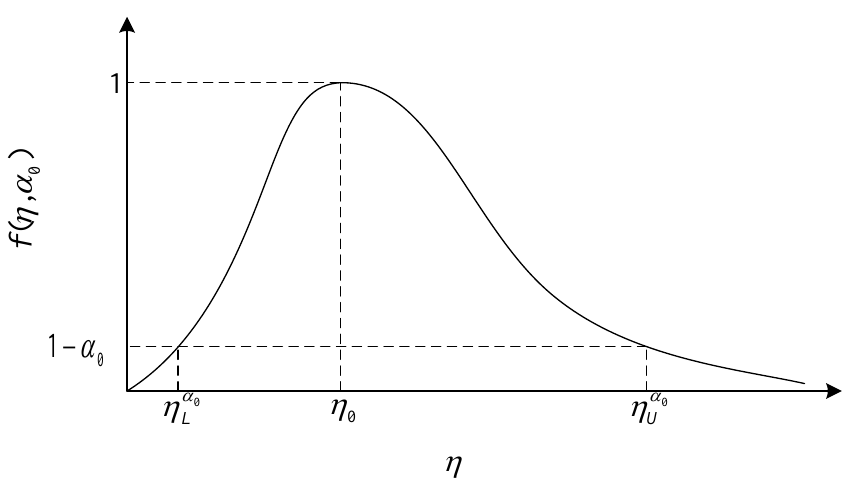
Figure 2. Diagram of the PG membership function for failure rate cumulated